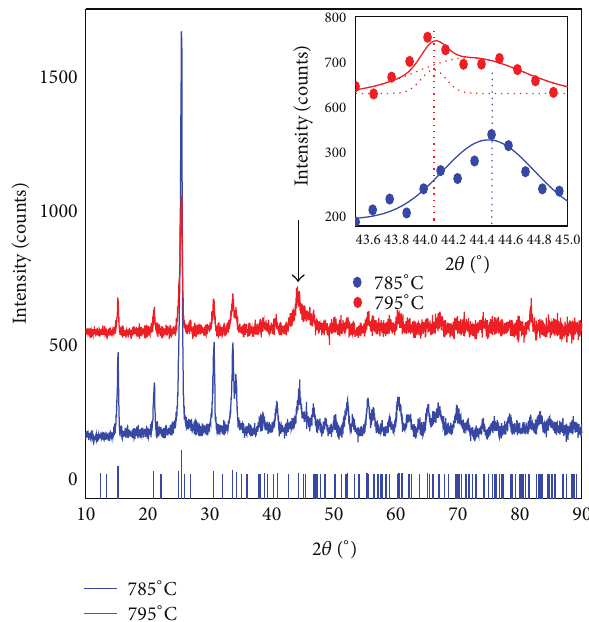
Figure 2: XRD patterns of the final products of alum salt calcination at 785 and 795 ∘ C for